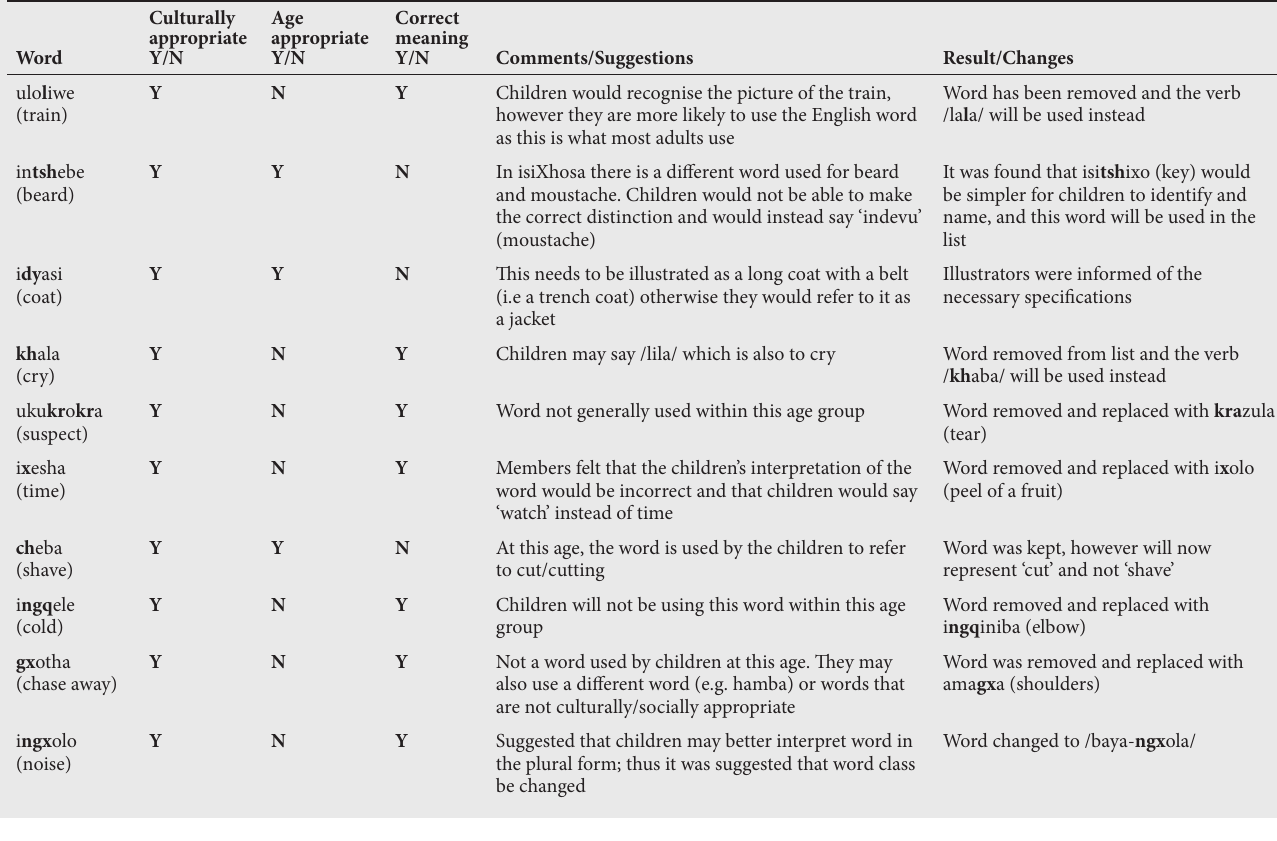
Table 1. Example of a checklist used in an expert panel discussion of stimuli items for an isiXhosa speech assessment (based on Maphalala, 2012)